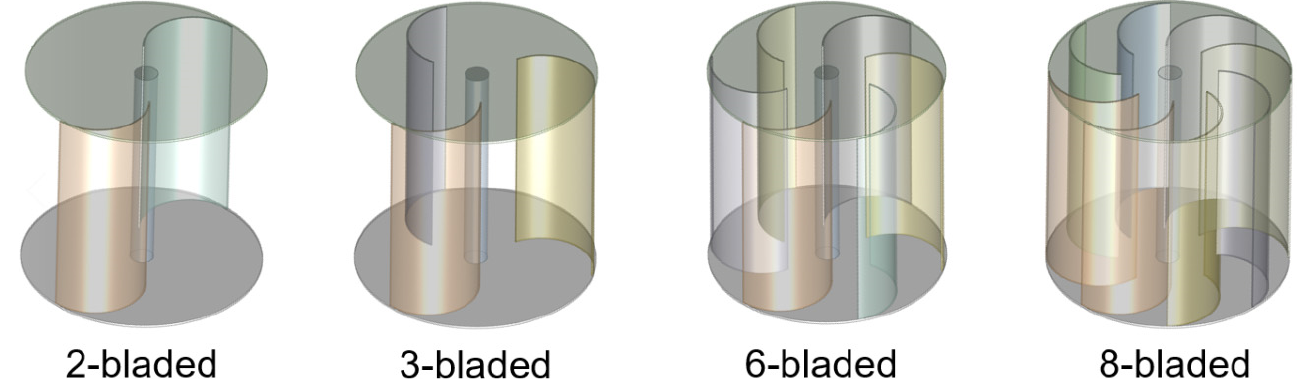
Figure 4. The geometry of the turbine for different numbers of blades ( α = 0°, ψ = 135°). Data